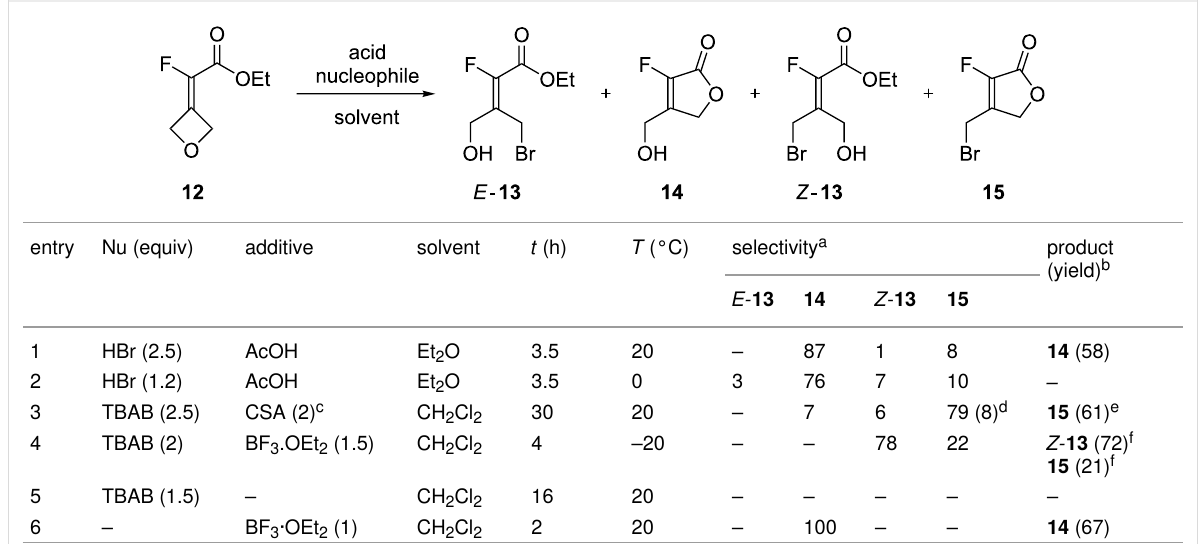
Table 4: Ring-opening reaction from acetate derivative 12